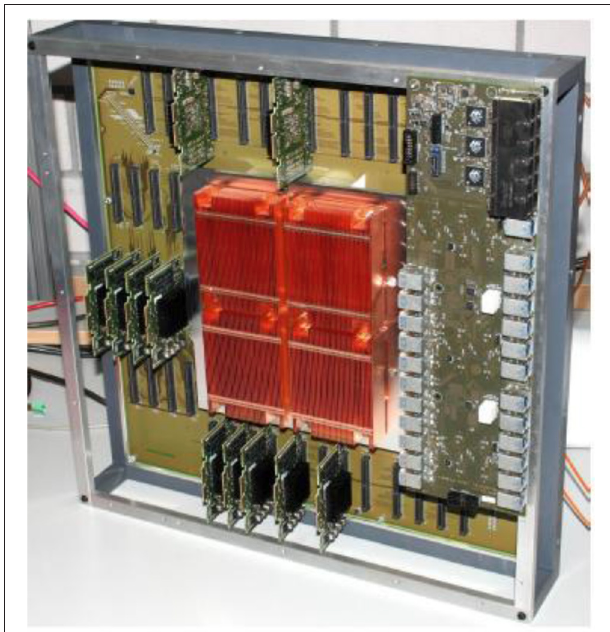
FIGURE 8 | Photograph of a BrainScaleS wafer module with part of the communication boards removed to show the main PCB. The wafer is located beneath the copper heat sink visible in the